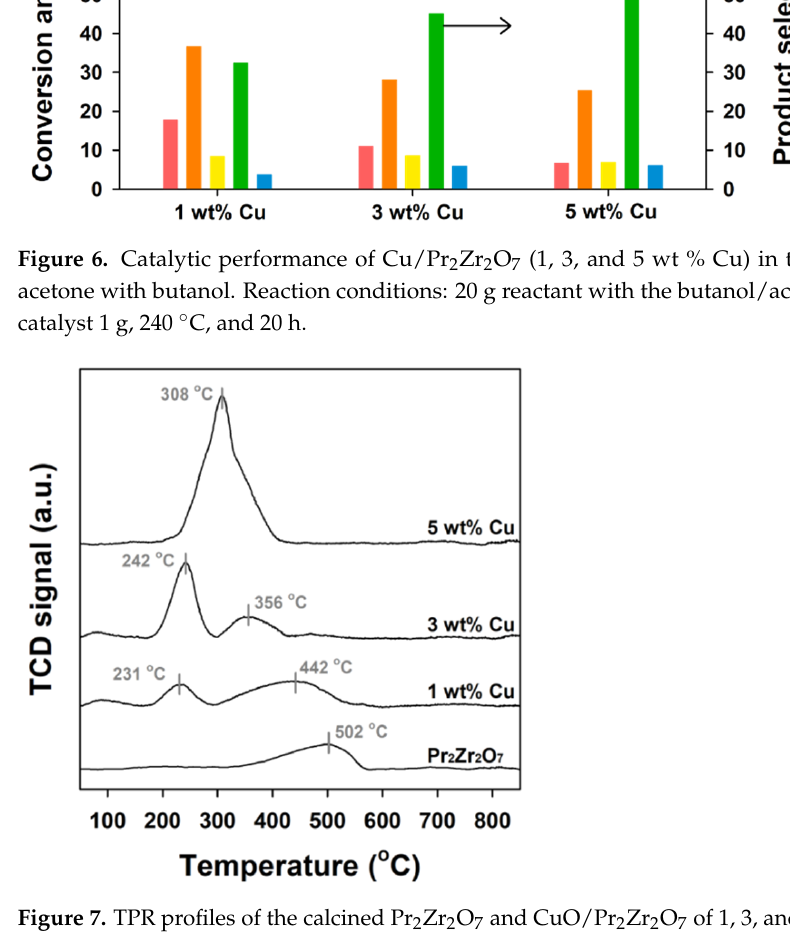
Figure 7. TPR profiles of the calcined Pr 2 Zr 2 O 7 and CuO/Pr 2 Zr 2 O 7 of 1, 3, and 5 wt %